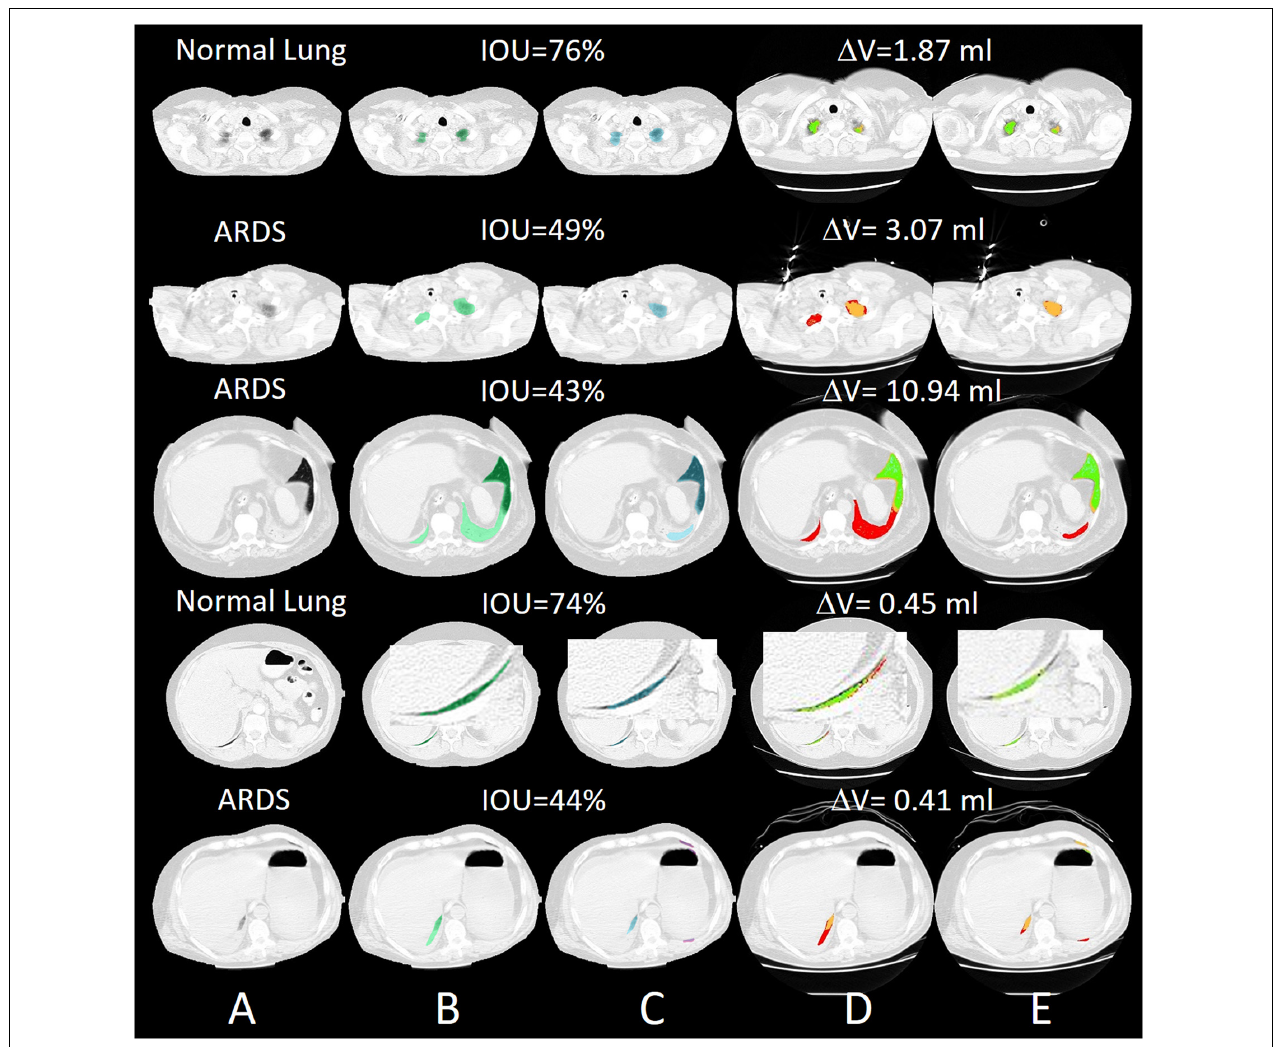
FIGURE 9 | Selected slices with very poor segmentation results with an IOU of up to 43% in ARDS Lung. Most of the lungs were poorly recognized in the peripheral areas. (A) preprocessed CT, (B) ground truth (transparent green), (C) predicted mask (transparent blue), (D) quantitative calculations within the manual ROI and (E) quantitative calculations within the automatic ROI (green = normally aerated, blue = overextended, orange = badly aerated and red = not